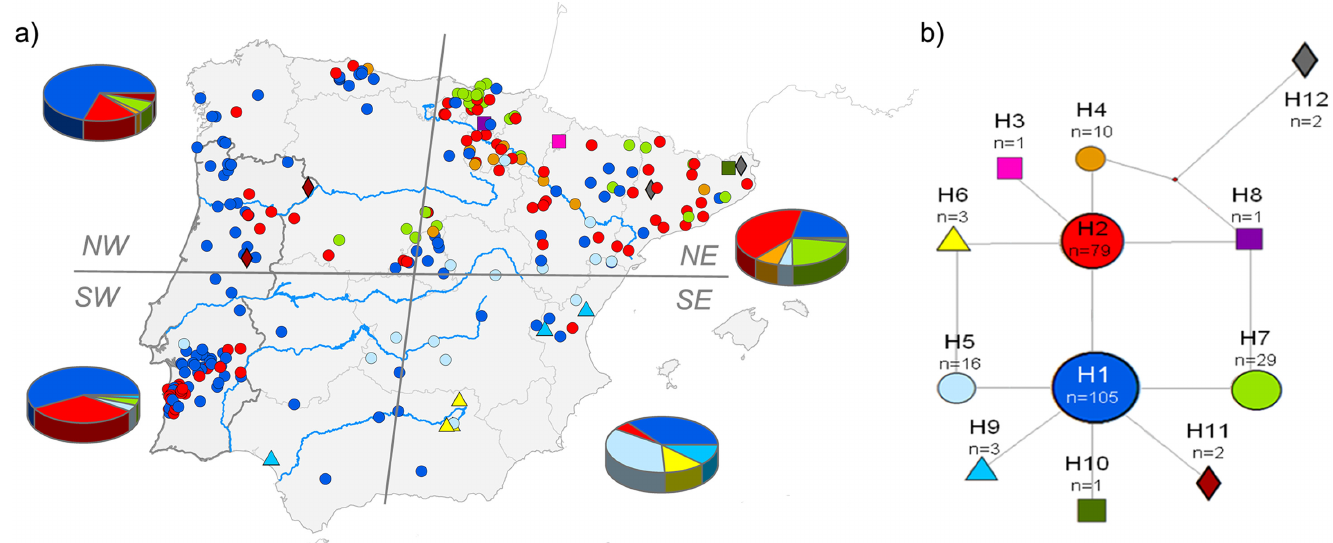
Fig 2. a) Geographic location of the 252 individuals sequenced for mtDNA in the Iberian Peninsula, which was divided into four regions (NE, NW, SE and SW). Pie charts represent the proportion of the samples with each haplotype in each region. b ) Median-joining network of the 252 mtDNA sequences. Each haplotype (H1 to H12) is represented by a different coloured symbol (the same in the map). Grey numbers on the lines connecting haplotypes indicate the position of mutations in the alignment. “ n ” is the number of sequences in each haplotype. Less frequent haplotypes are represented by a square (n = 1), diamond (n = 2) and triangle (n = 3) to facilitate their